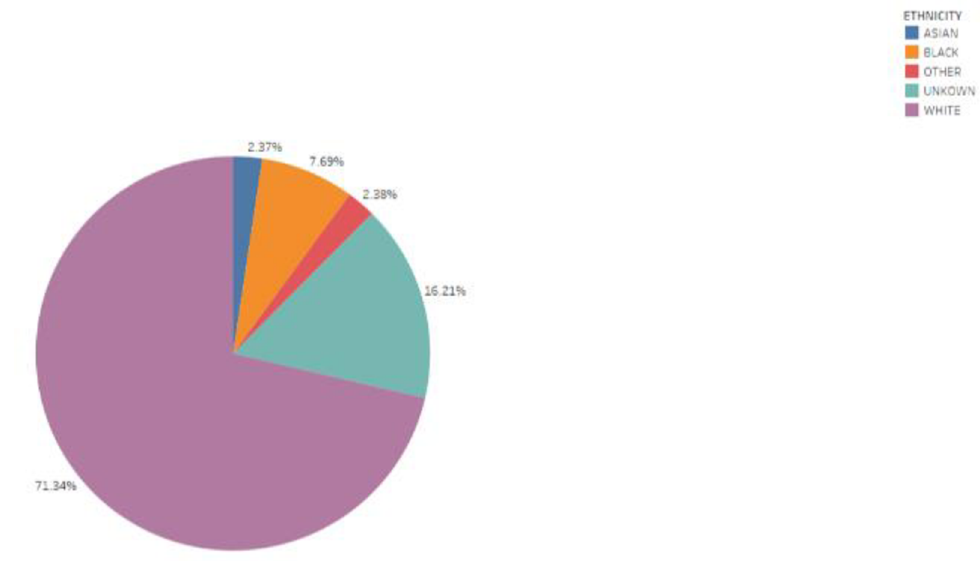
Fig 4. Ethnic distribution of all patients (Total number of patients is 38161).